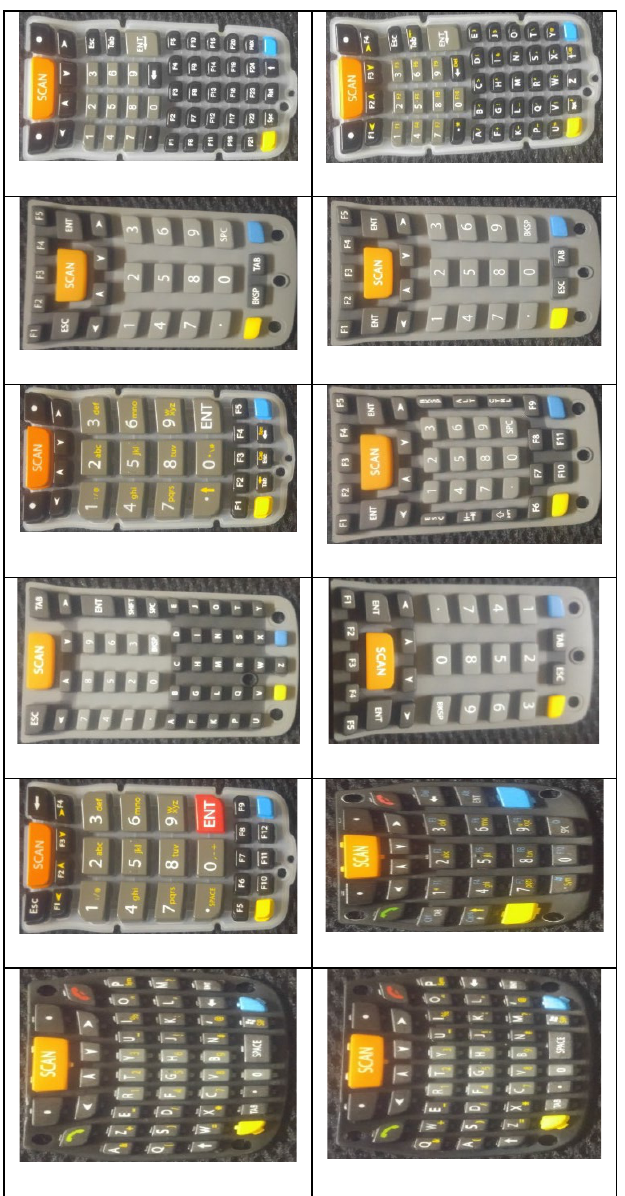
Figure 2. (a) Keypad supplier; (b) Full system; (c) LED and camera; (d) Sample image captured by the system; (e) 14 types of keypad used in this